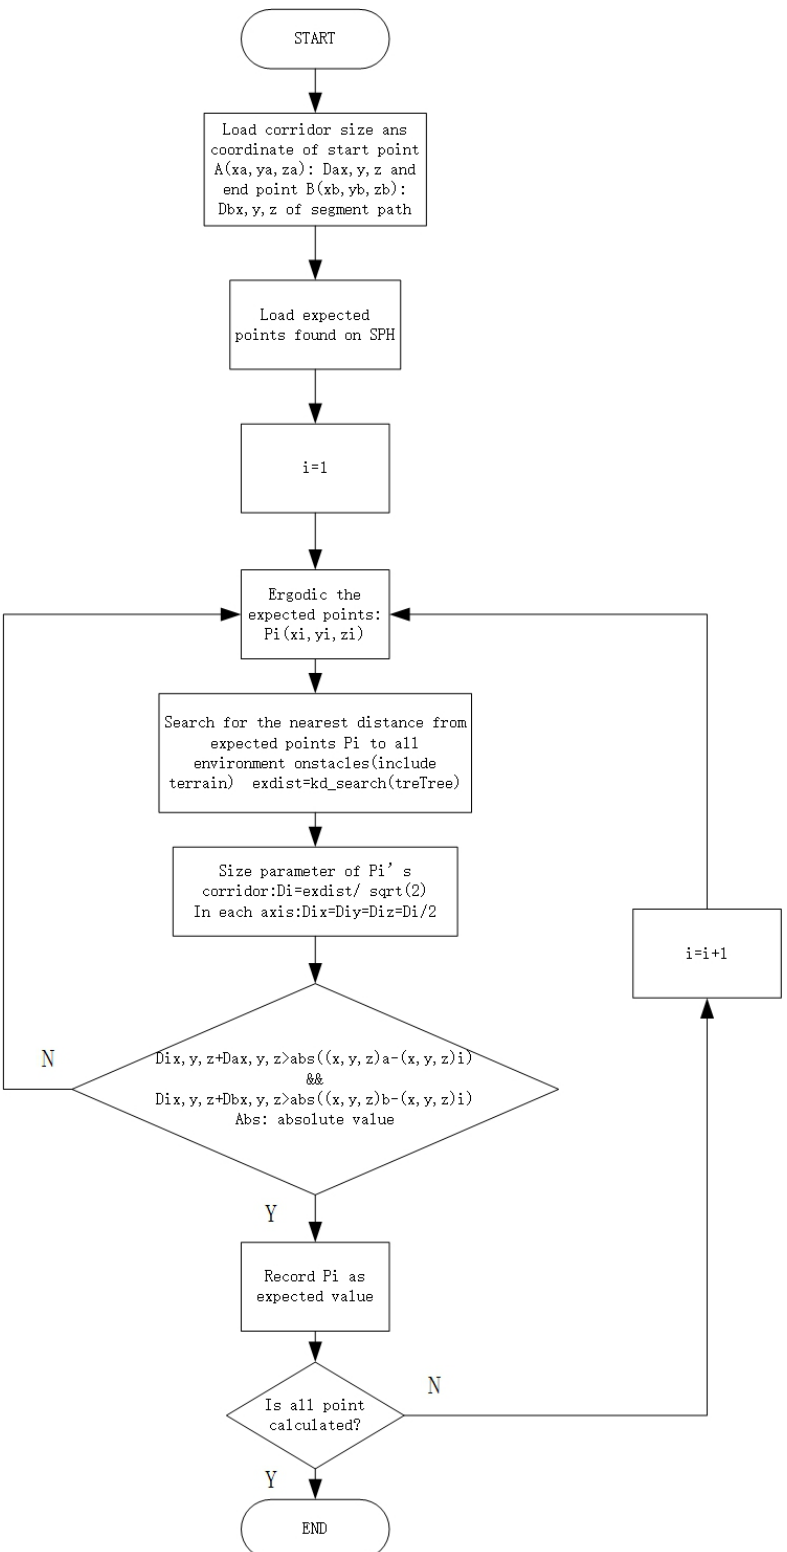
Figure 12. Algorithmic framework of obset (the set of collision-free spots on SPH 2,3,.. s )